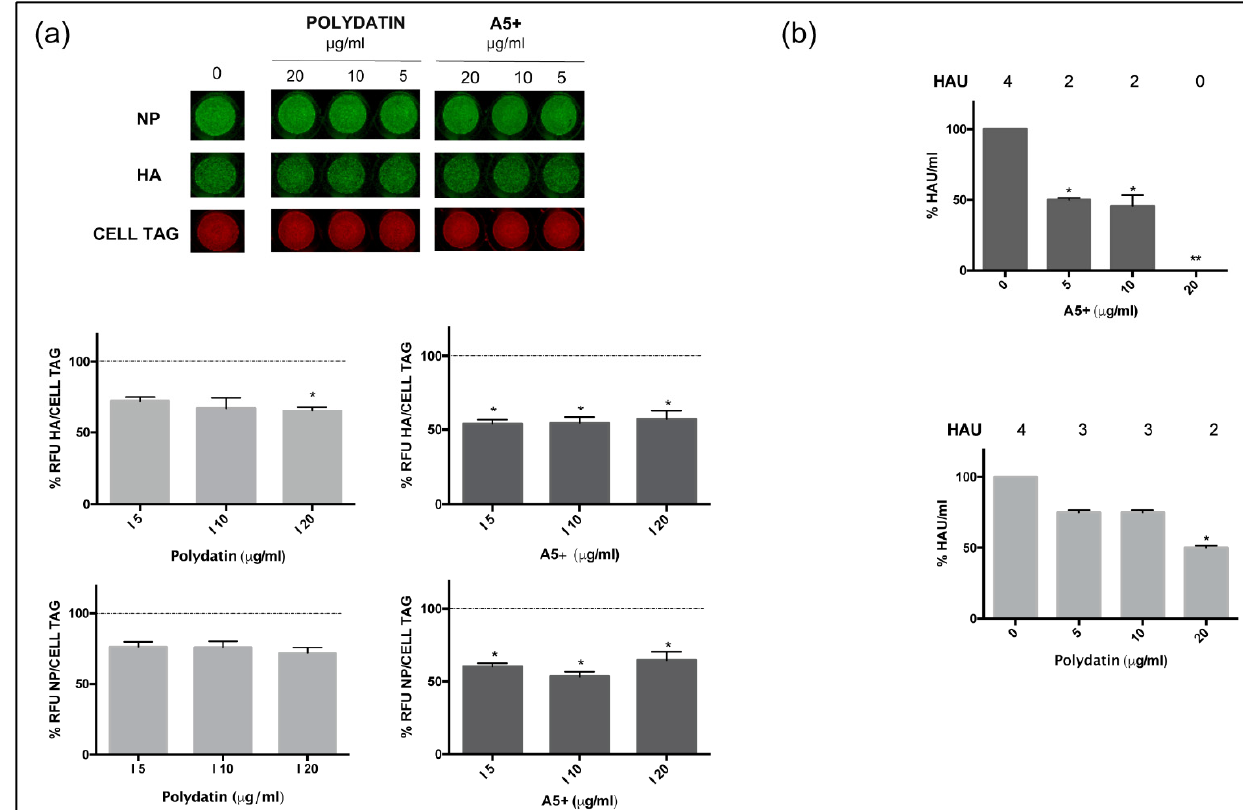
Figure 2 . A5+ compound inhibits influenza A virus replication. ( a ) In Cell Western assay (ICW) of Hemagglutinin (HA) and Nucleoprotein (NP) expression in infected cells treated with different concentrations of polydatin or A5+ (5–20 µg/mL) for 24 h. As control, infected cells were treated with H 2 0 or DMSO at the same conditions and reported as 0 µg/mL. The green fluorescence is representative of viral proteins expression and red fluorescence of Cell Tag staining of cell monolayer. In the graphs below is reported the percentage (%) of relative fluorescence units (RFU) of HA or NP proteins expression normalized to Cell Tag and compared to control which is indicated by the dashed black line (considered as 100%). Data are expressed as means ± S.D., obtained from two independent experiments, each performed in duplicate (* p < 0.05 vs. infected solvent-treated cells). ( b ) Viral titer measured in the supernatants of infected treated cells (0 to 20 µg/mL of Polydatin or A5+) by Hemagglutination assay (HAU). In the graphs are represented the percentage (%) of HAU/mL compared to infected untreated condition. Data are the mean ± S.D. of two separate experiments (* p < 0.05 and ** p < 0.001 vs. Infected untreated cells, I).